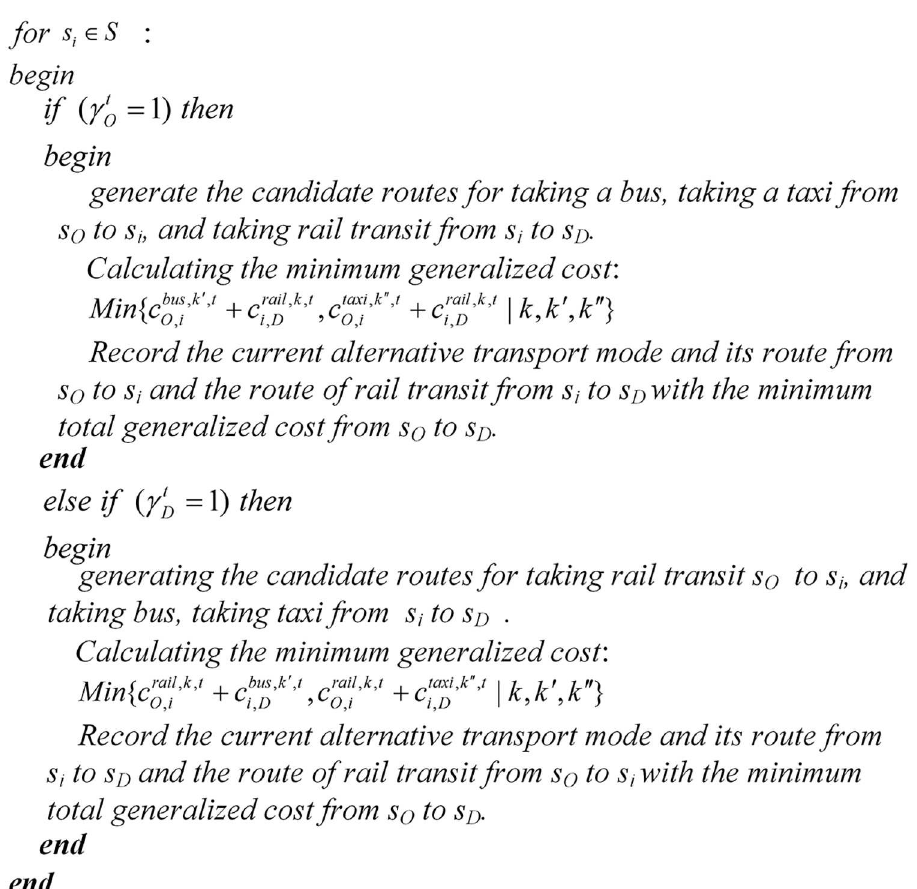
Fig 6. The basic model solver module. For each passenger, all stations will be traversed and examined with the objectiveof passengerbehavioroptimizationmodel. And then the station with the minimum model objectivewill be chosen as the alternative